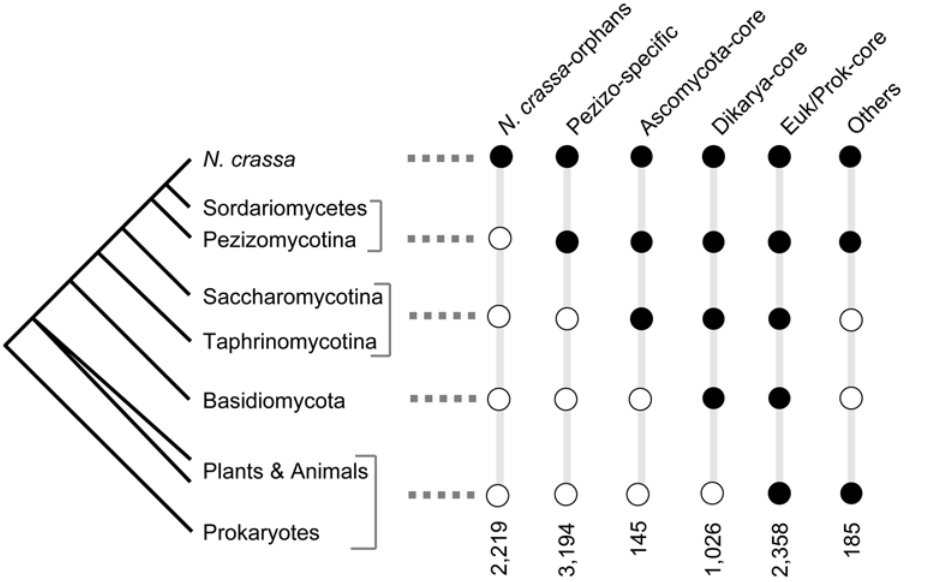
Figure 1. Lineage specificity classification of predicted N.crassa protein coding gene (PCG) set based on phylogenetic distribution. A black circle indicates that the gene homolog is present in the corresponding lineage; a white circle means it is absent. Number of PCGs in each LS group is shown at the bottom. Note that N. crassa is a member of the class Sordariomycetes, which is within the Pezizomycotina.